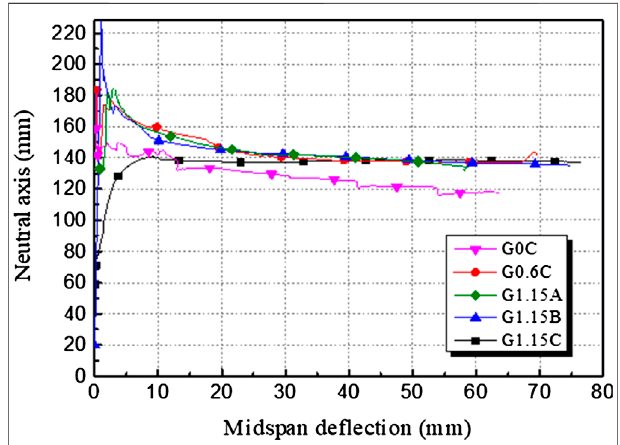
FIGURE 14 | Location of the neural axis.